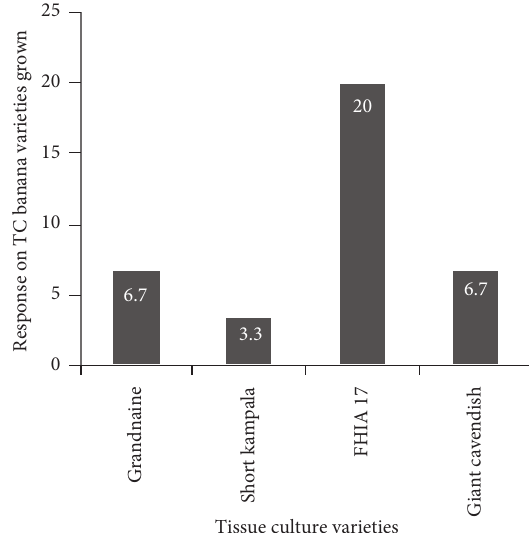
Figure 12: Tissue-cultured banana varieties grown in Embu